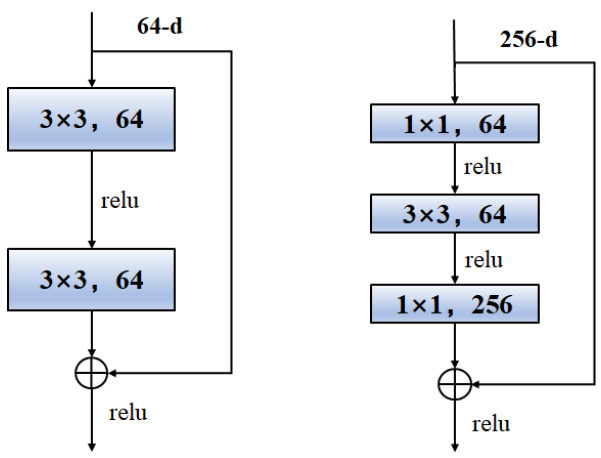
Figure 5. BasicBlock and